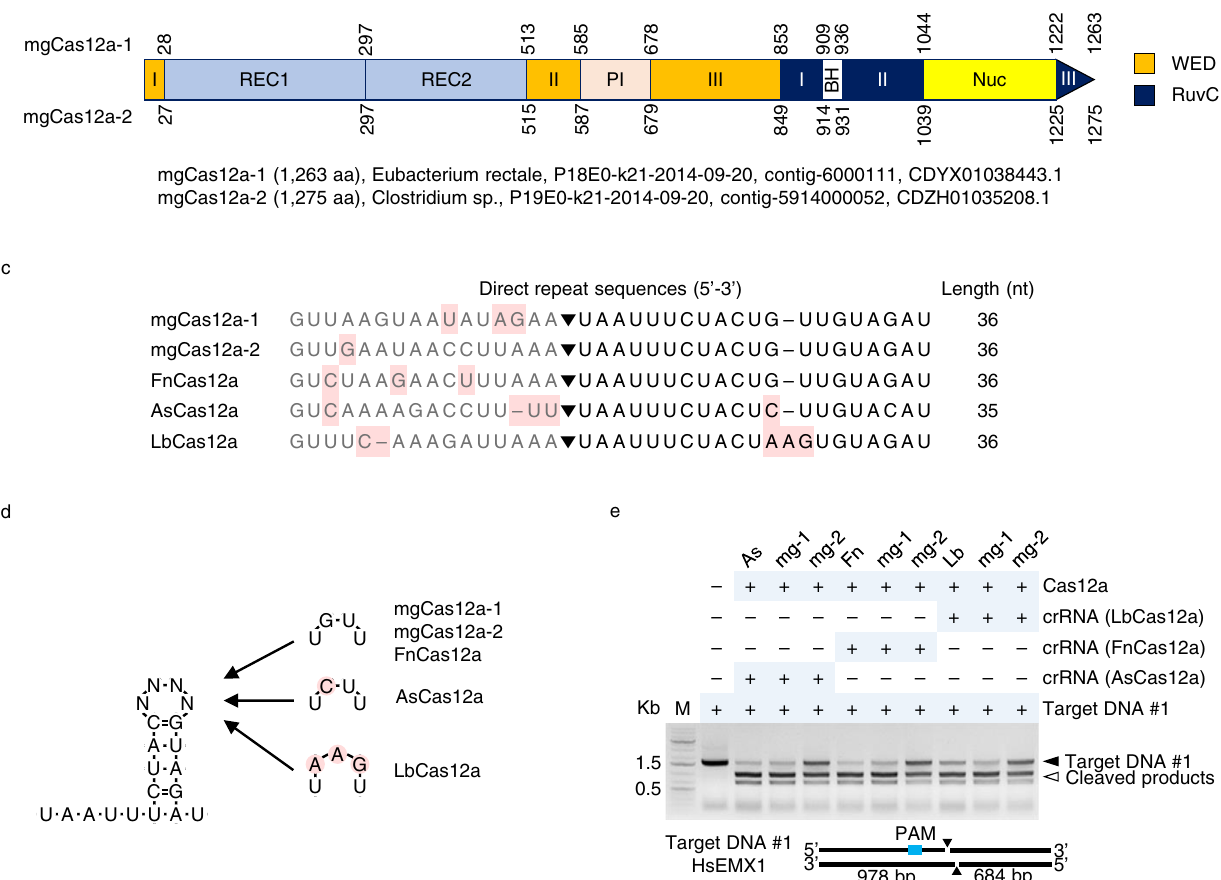
Figure 2. Identification of a functional crRNA for mgCas12a. ( a ) CRISPR loci of mgCas12a-1 and mgCas12a-2 . Unlike other class 2 type V-A CRISPR Cas12a systems, no Cas1 sequence was found at the mgCas12a-1 locus, while no gene encoding an adaptor Cas protein was found at the mgCa12a-2 locus. Seven repeats and six spacers were identified within the CRISPR array of each mgCas12a locus. ( b ) Domain structure of mgCas12a-1 and mgCas12a-2. Protein domains were predicted using structure-based alignments with the amino acid sequences of AsCas12a, FnCas12a, and LbCas12a. Amino acid numbers between each domain are shown between each domain; the putative gut bacterial species, sequence identifier, and GenBank accession numbers are given below the diagrams. WED, wedge domain; REC, recognition domain; PI, PAM interaction domain; RuvC, RuvC nuclease domain; BH, bridge helix domain; Nuc, nuclease domain. ( c ) Alignment of direct repeat sequences and predicted 5 ′ handle structures from the five Cas12a orthologous loci. The sequences removed during crRNA maturation are shown in gray. Triangle, putative cleavage site during crRNA processing. Mismatching 5 ′ handle sequences are highlighted in pink. ( d ) 5 ′ handle structure of mature crRNA from Cas12a . ( e ) Compatibility of mgCas12a with various crRNA forms for target DNA cleavage. Three types of crRNA (from the AsCas12a , FnCas12a , or LbCas12a loci) were used to test mgCas12a RNP-mediated target DNA cleavage activity. A partial amplicon of HsEMX1 was used as target DNA #1. Filled arrowhead: Target DNA, 1,662 bp; unfilled arrowhead: Cleaved products, 978 bp + 684 bp. Original gels are presented in Supplementary Fig.